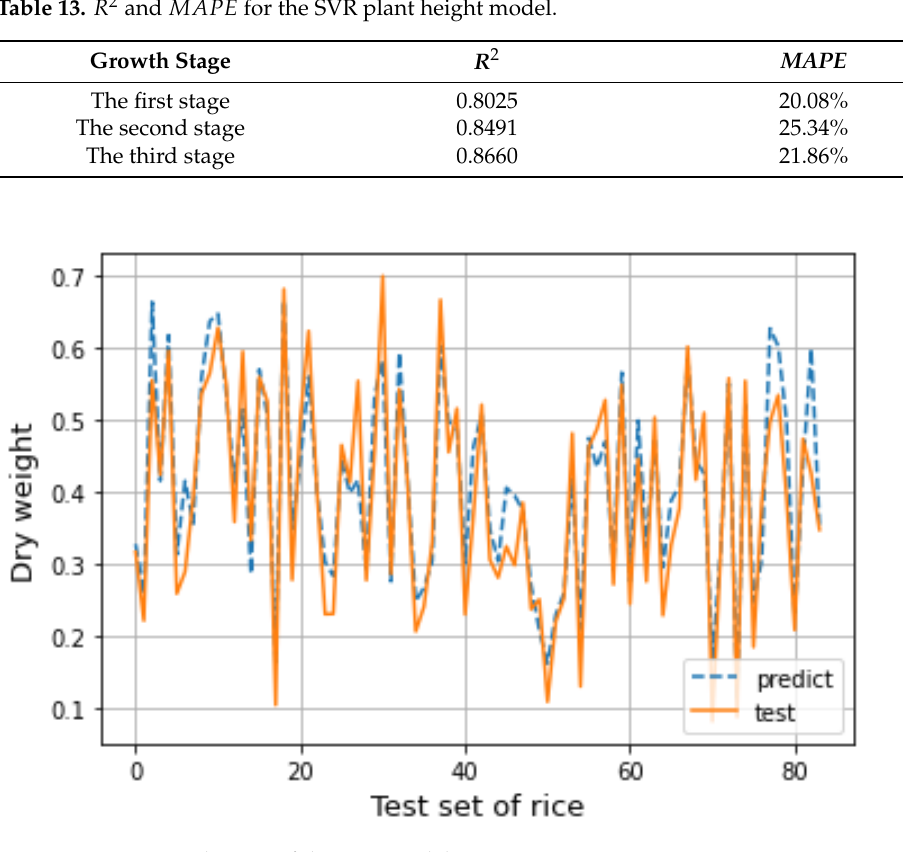
Figure 9. Fitting renderings of the SVR model.